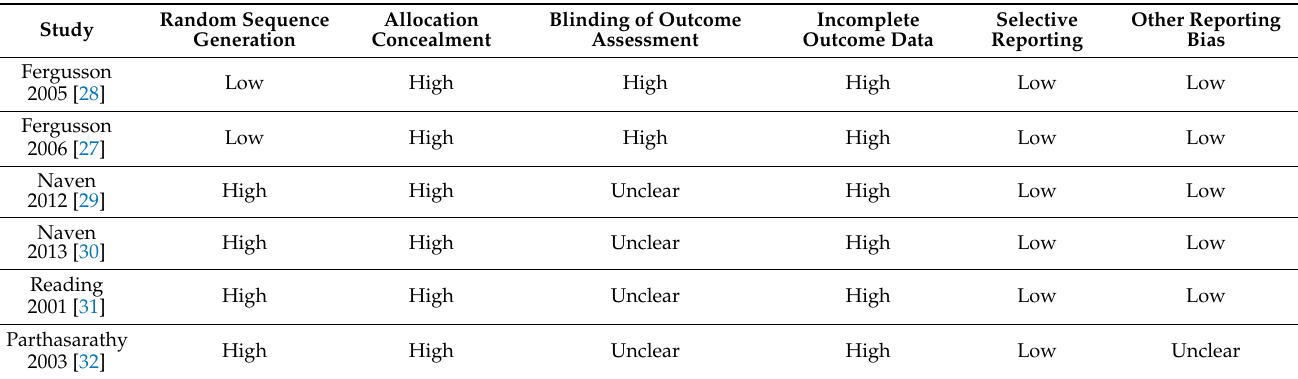
Table 2. Risk of Bias Summary—based on GRADE